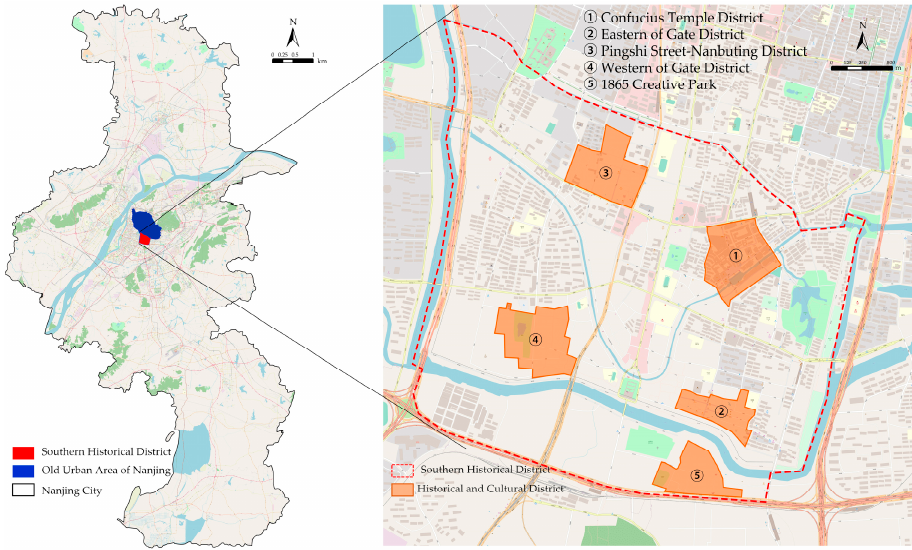
Figure 1. Location of case study (source: Open Street Map).